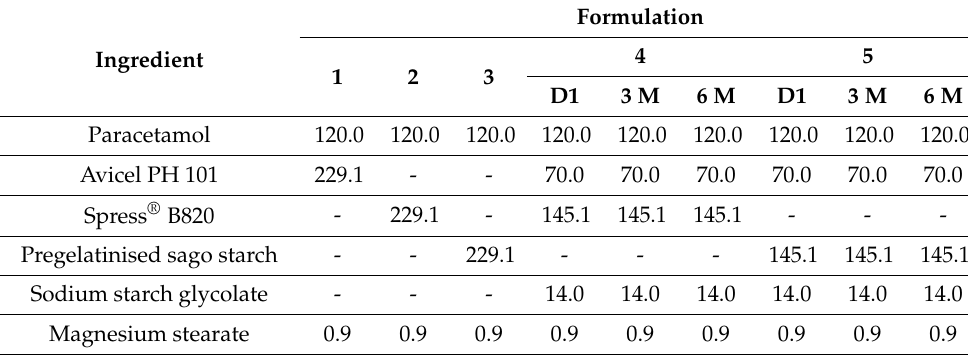
Table 1. Formulation of paracetamol